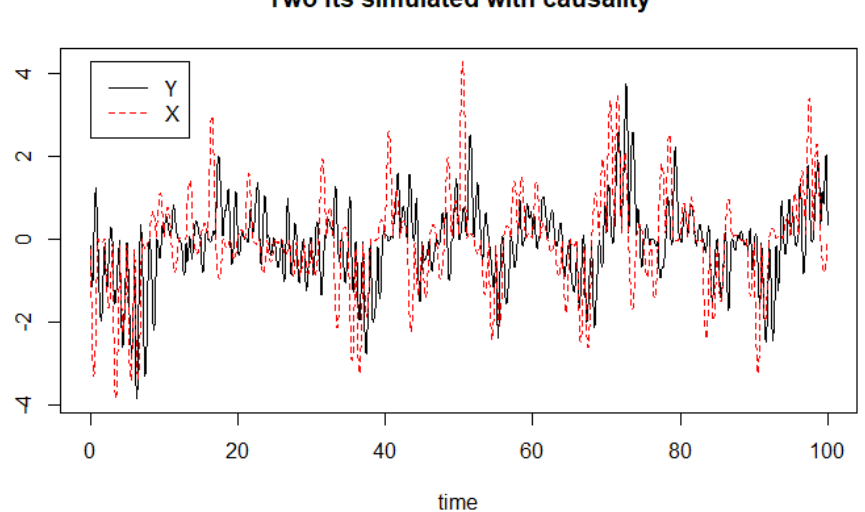
Figure 5. The trajectory of two functional time series with a causal